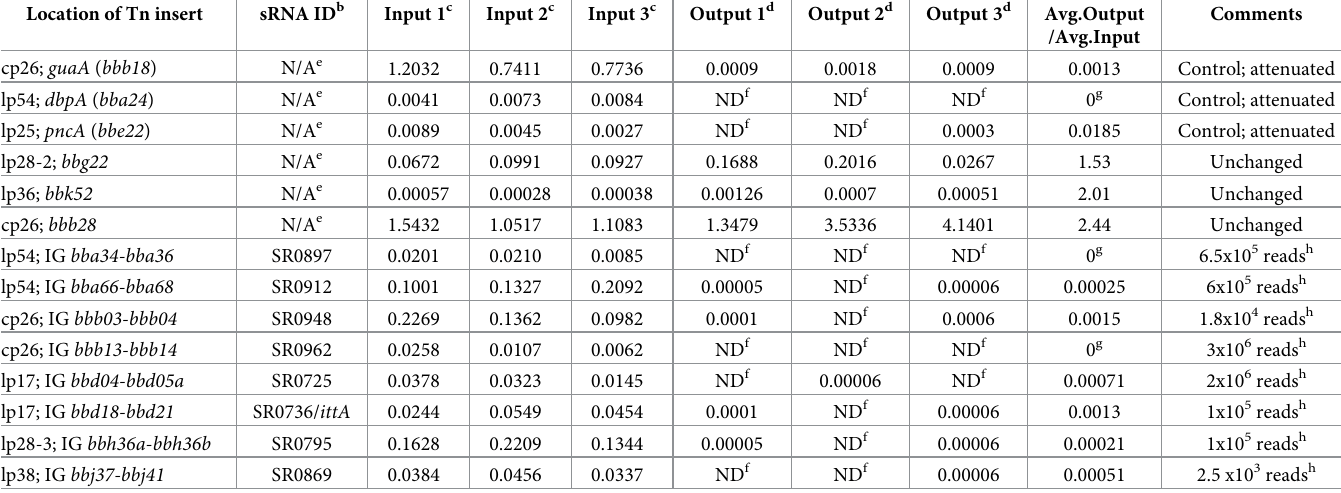
Table 1. Reduced prevalence of candidate sRNA mutants during murine infection, based on Tn-seq a . Genetic mutations that either reduce ( guaA , dbpA , pncA ) or do not affect infection ( bbg22 , bbk52 , bbb28 ) are included for comparison. Location of Tn insert